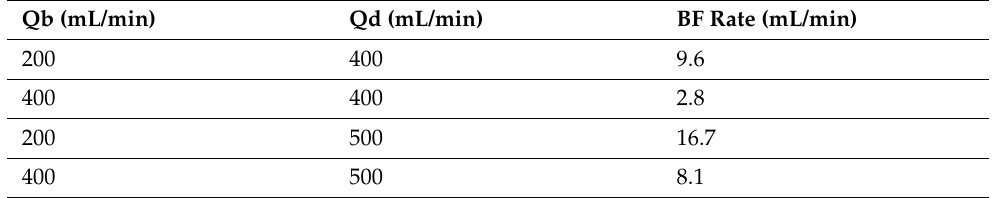
Table 2. Back-filtration rate at different operating